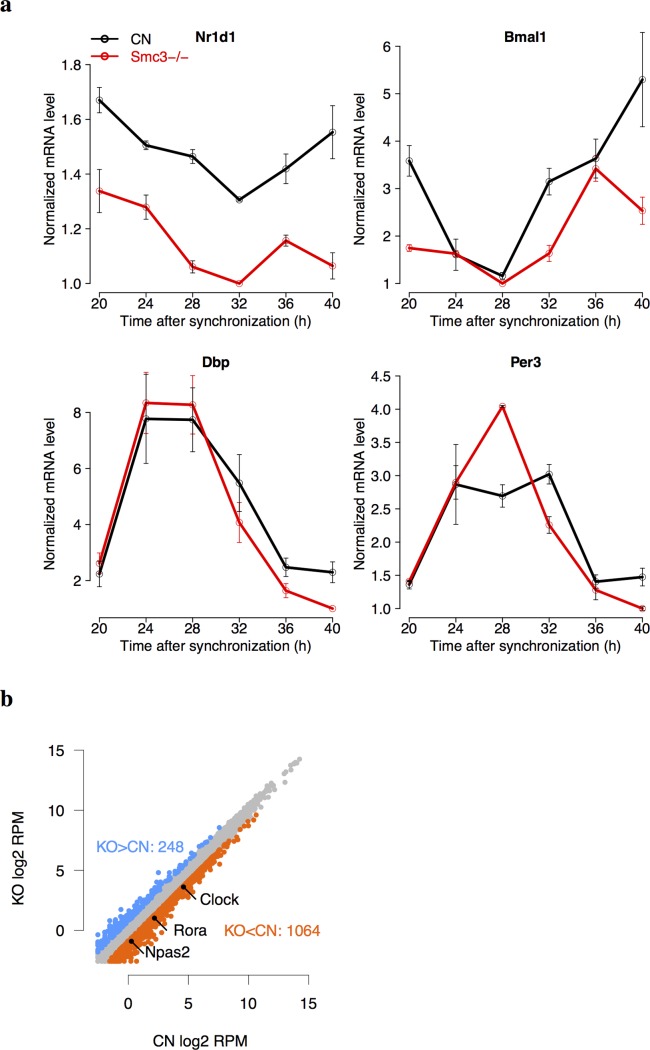
Cohesin knockout in MEFs.(a) The RT-PCR results of the expression of clock genes in control (CN) and Smc3-/- (KO) MEFs. Gene expression were measured every 4 hr for 24 hr after the cells were synchronized by 1-hr dexamethasone treatment at CT0. Each data point contained two biological replicates and three technical replicates. All four clock genes showed significant circadian expression in CN and KO by cosine fitting (p < 0.05) except for Nr1d1 in KO. ANOVA analysis showed that the expression of Nr1d1 has significant difference between CN and KO (p = 10−7). (b) The scatterplot of global gene expression from RNA-Seq in Smc3-/- and control MEFs. 20-hr and 32-hr samples were combined together to determine the differentially expressed genes. Core clock genes including Clock, Rora, and Npas2 were under-expressed in cohesin KO.